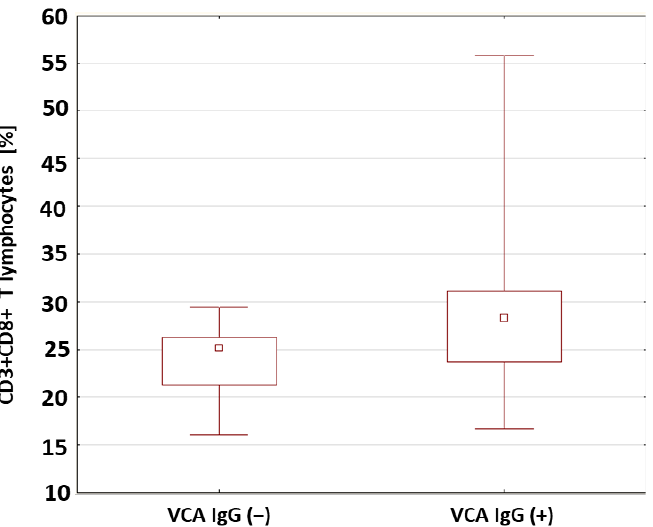
Figure 4. Comparison of the percentages of CD8+CD3+ T cells in a group of patients with type 1 diabetes in relation to the presence of anti-VCA antibodies in the IgG class. 2.6. Evaluation of the Percentage of Lymphocytes Expressing Selected Activation Markers in Patients with Type 1 Diabetesin Relation tothe Presence of Antibodies Against EBV Antigens The percentages of T and B lymphocytes expressing CD69 antigens in a group of patients with type 1 diabetes was analyzed in relation to the presence of anti-VCA anti- bodies in the IgM and IgG classes. The results obtained are presented in Table 6. There were no significant differences in the percentages of the T and B lymphocytes expressing the CD69 antigen in the patients with type 1 diabetes in relation to the presence of anti- VCA antibodies in the IgM class. However, it was shown that the percentage of CD8+CD69+ T cells was significantly lower in the group of patients with anti-VCA anti- bodies in the IgG class ( p = 0.029; Figure 5A). Moreover, based on the conducted analysis, no statistically significant differences were found in the percentage of T and B lympho- cytes expressing the CD69 antigen in the patients with type 1 diabetes in relation to the presence of anti-EBNA-1 antibodies in the IgG class. Table 6. Comparison of the percentage of lymphocytes with the expression of the CD69+ antigen in patients with type 1 diabetes in relation to the presence of anti-VCA antibodies in the IgM and IgG class and anti-EBNA-1 in the IgG class. Parameter